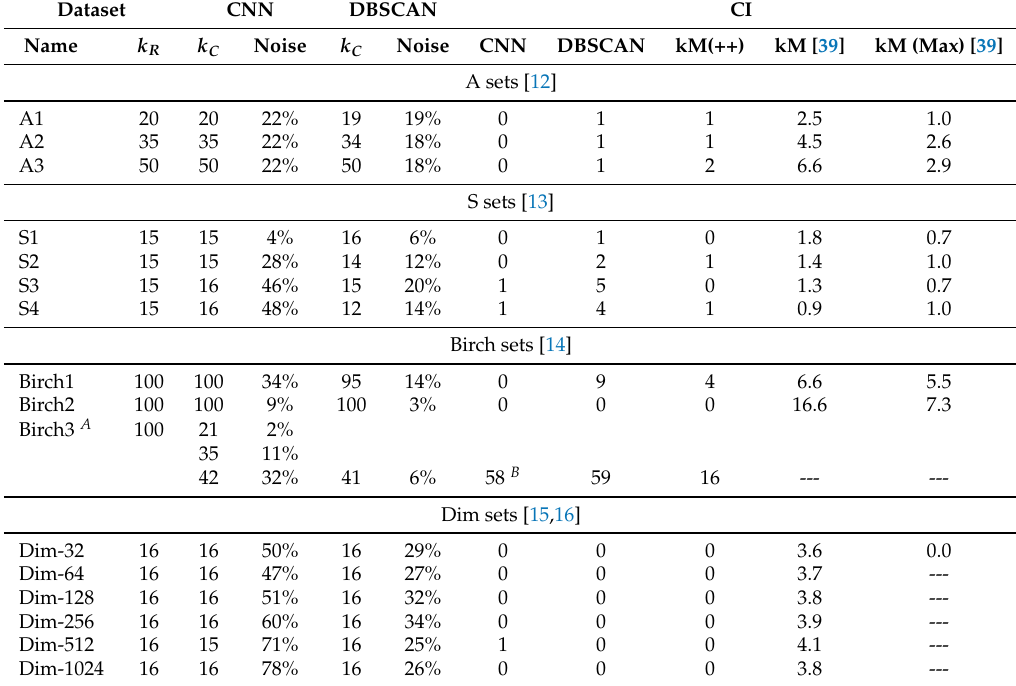
Table 3. Clustering results for different datasets. The left part shows the number of isolated clusters k C for the common nearest neighbor (CNN) and the DBSCAN algorithm (compared to the reference number of cluster k R ) as well as the percentage of data points declared as noise. The right part shows the centroid index at cluster level (CI) [37] using the CNN algorithm, the DBSCAN-algorithm and the kMeans(++) algorithm ( kM (++) ) [40] as implemented in pyEMMA [41]. The CI values are compared to reference values provided by the authors of [39] for the kMeans algorithm [42] using a random initialization (kM) and using a further point heuristic (Max) [43] initialization. The reference data were averaged over 5,000 runs. A Hierarchical clustering was necessary. B After the last clustering